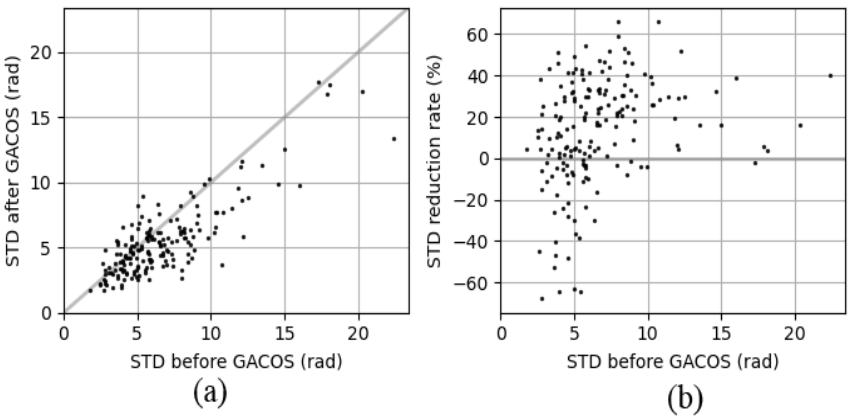
Figure 17. Correlation diagram of phase standard deviation before and after GACOS correction: ( a ) is the phase difference before and after correction; ( b ) is the change rate of phase standard deviation before and after correction. The blue is the space-time baseline generated after the overall interference pair quality inspection, and the red is the unqualified interference pair after the loop-closure-phase inspection, which needs to be eliminated.